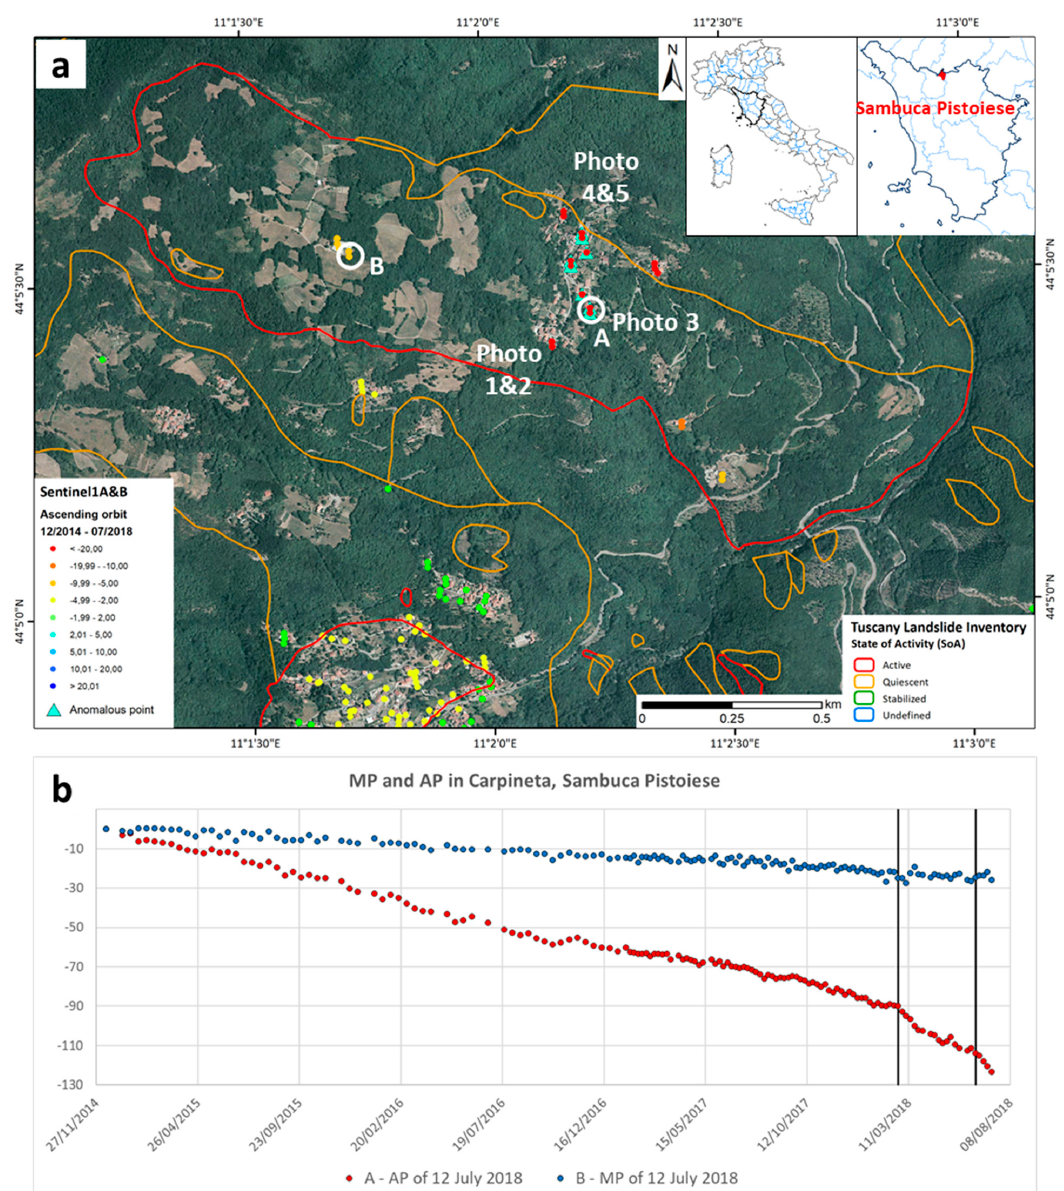
Figure 9 - Localization and deformation map of the area of Carpineta landslide (a). Inset (b) shows 2 time series of MP without trend changes (blue) and with trend change higher than 10 mm/yr